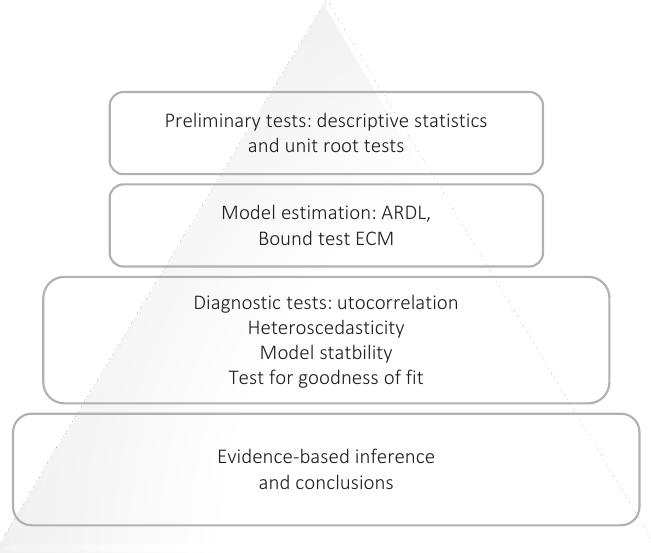
Figure 1. Estimation procedure of the